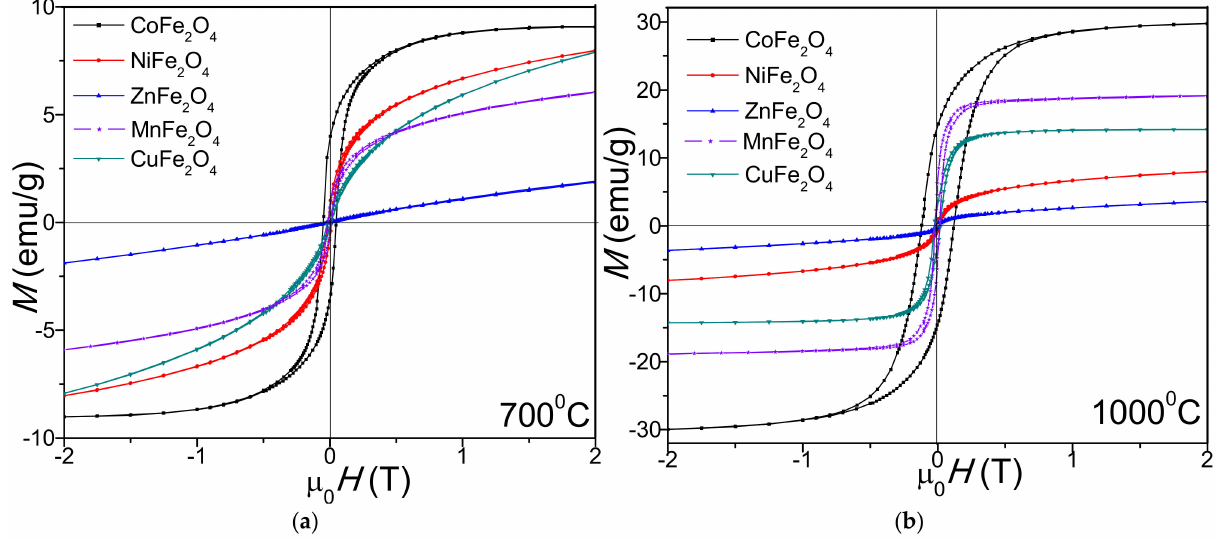
Figure 4. Magnetic hysteresis loops of MFe 2 O 4 (M = Co, Zn, Ni, Cu, Mn) heat treated at 700 ◦ C ( a ) and 1000 ◦ C ( b ).